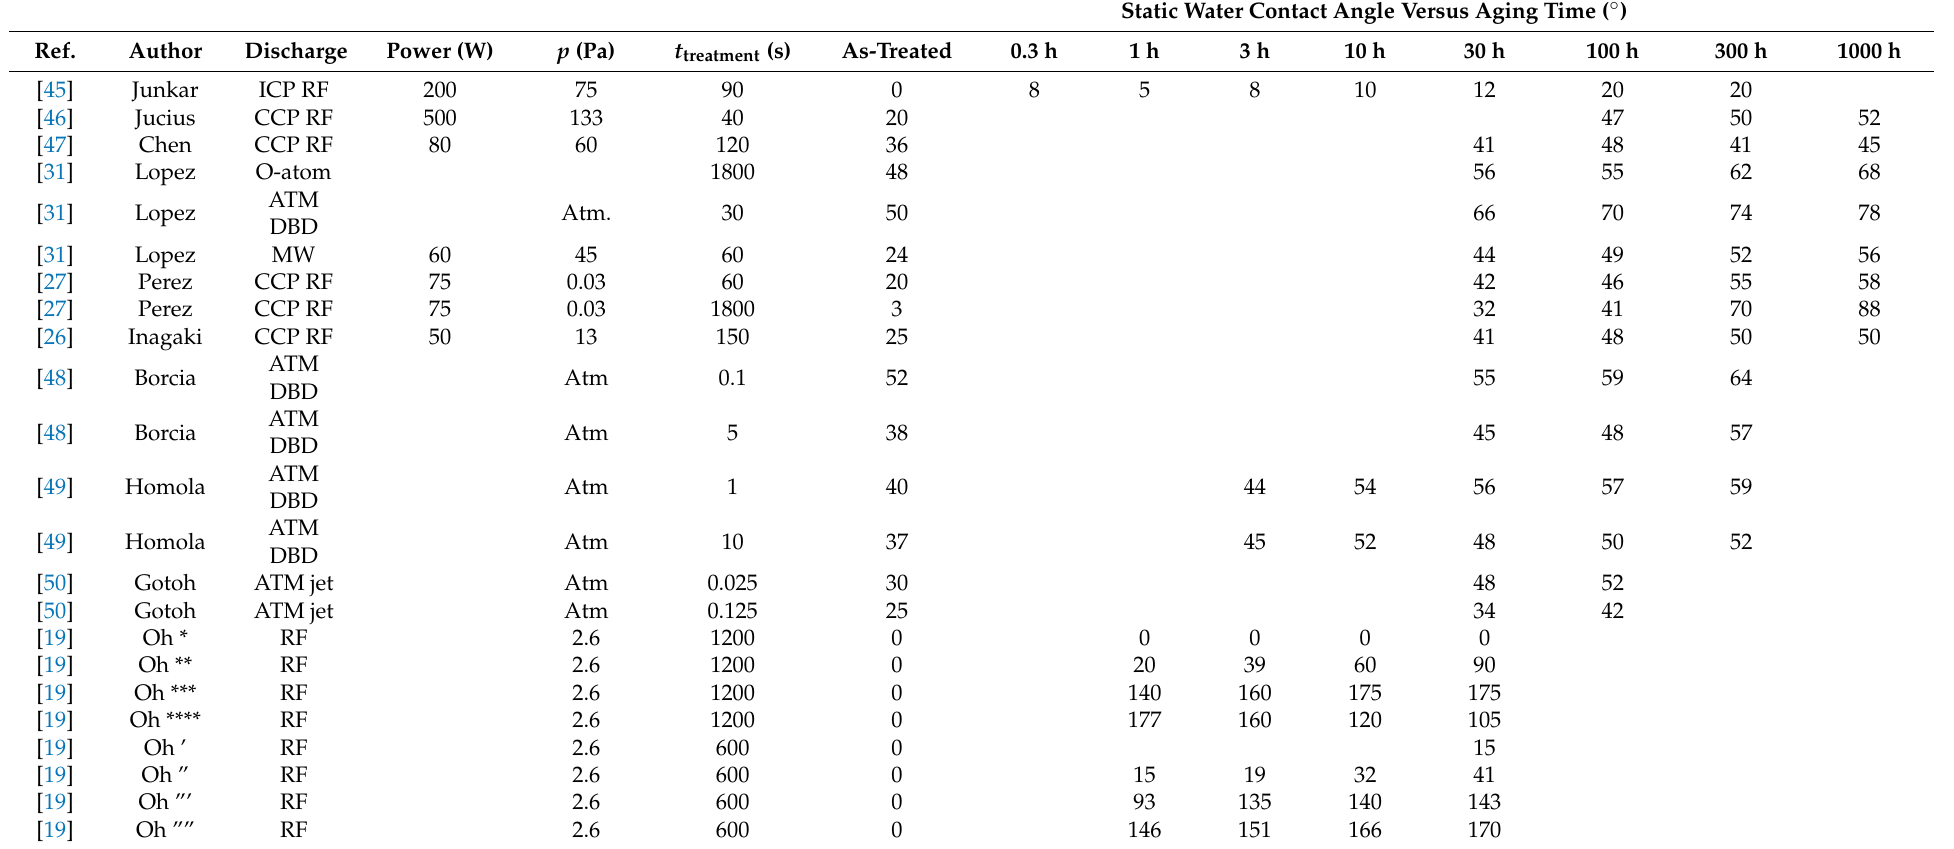
Table 1. The treatment conditions and reported WCA during aging of plasma-treated PET samples. Static Water Contact Angle Versus Aging Time ( ◦